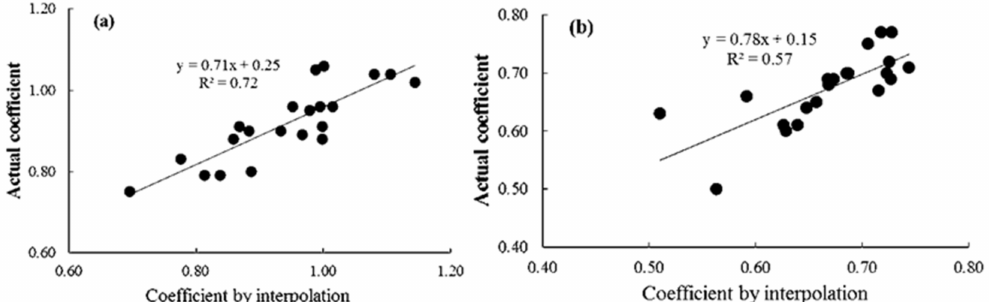
Figure 6. Comparison between the actual coefficient and the coefficient obtained by the interpolation method: ( a ) fertilization correction coefficient and ( b ) comprehensive correction coefficient.